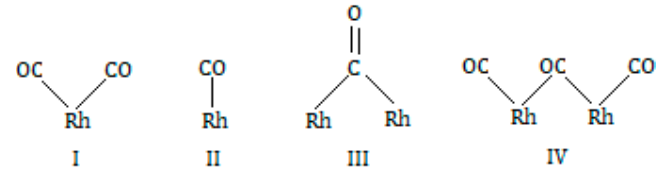
Figure 5. Scheme of three different primary types of Rh sites.